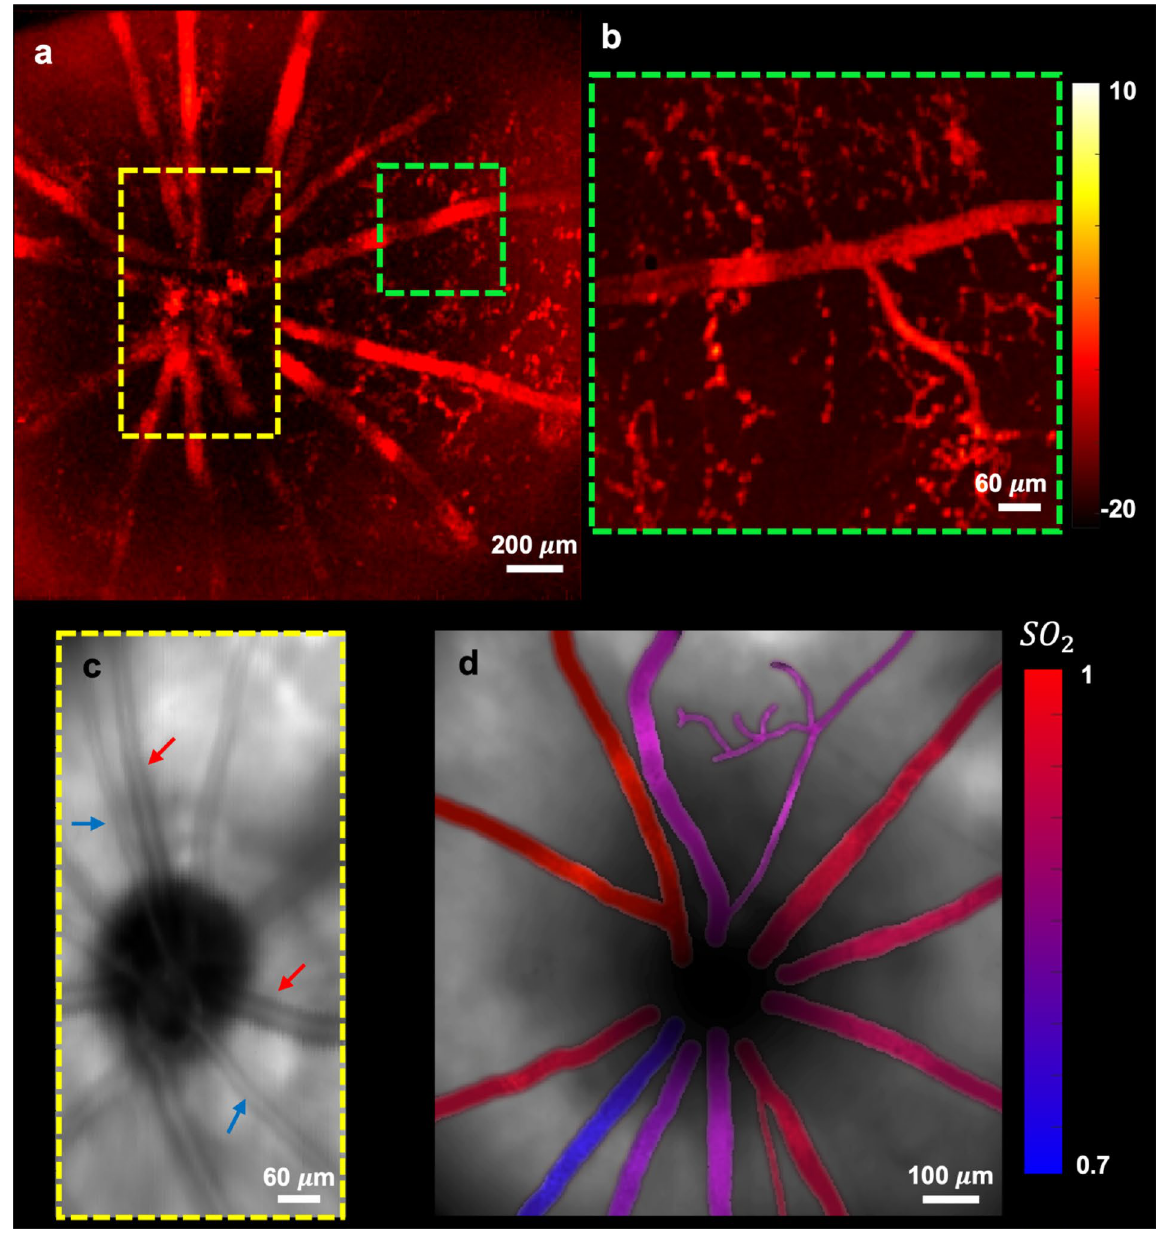
Figure 5. PARS retinal imaging. Fundus PARS image acquired from large vessels around ONH from a 2.6 × 2.6 mm area ( a ). zoomed-in section of one of the vessels acquired from a similar area with smaller vasculature ( b ). Fundus image acquired using scattering contrast of PARS system showing arteries (red arrows) and veins (blue arrows) ( c ). Oxygen saturation map in the retina obtained using multiwavelength PARS imaging ( d